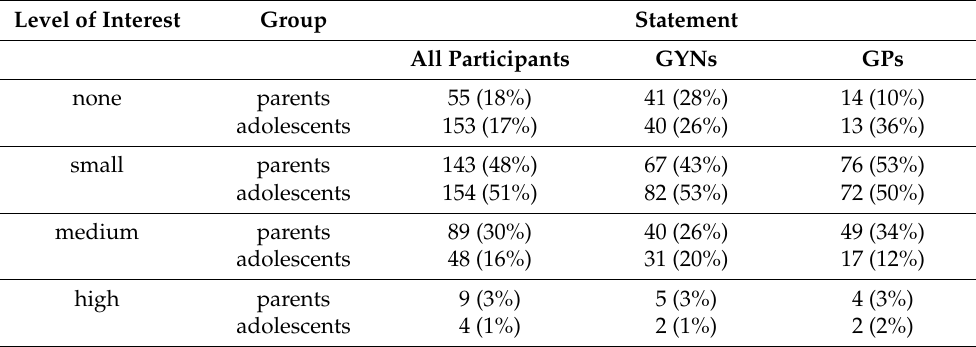
Table 4. Doctor’s opinion on the interest of parents and their children in HPV